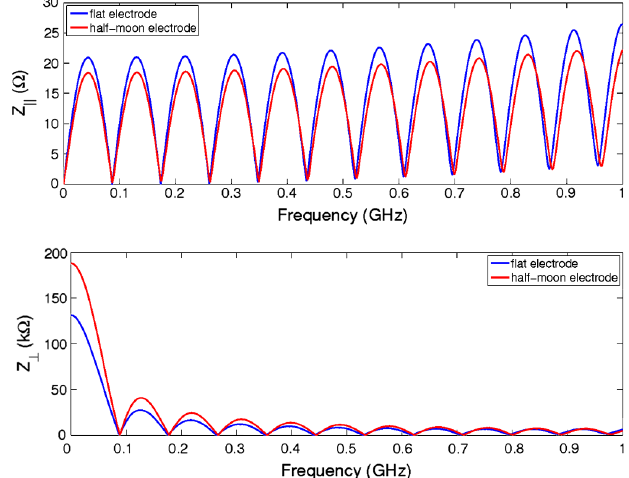
FIG. 11. Longitudinal (top) and transverse (bottom) beam coupling impedance results for untapered striplines from CST Particle Studio simulations for flat electrodes (blue) and half- moon electrodes